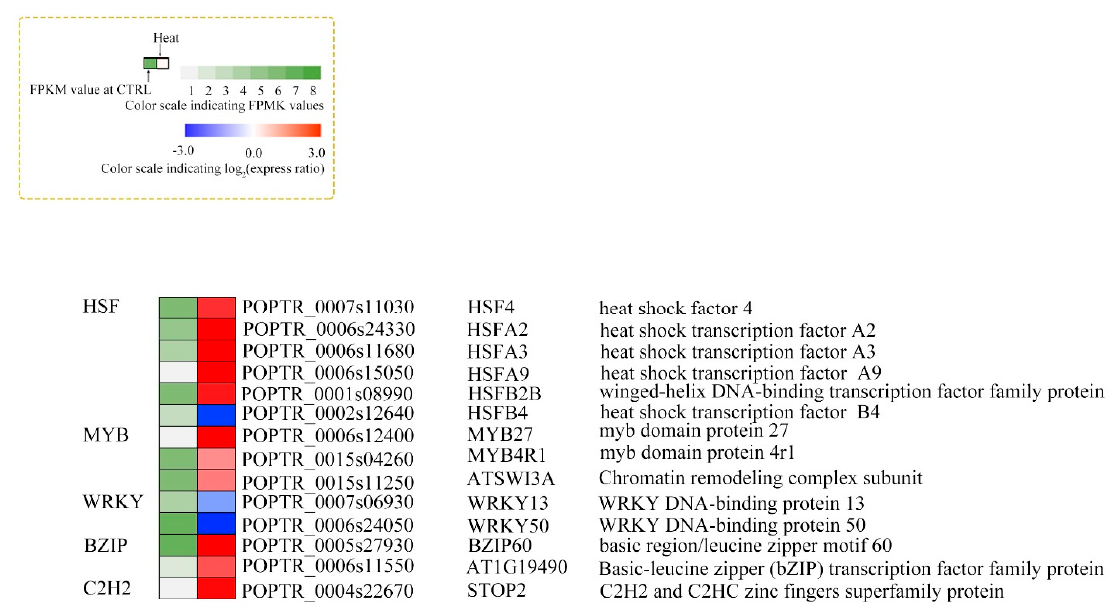
Figure 8. Heatmaps of changes in the expression of transcription factors under heat stress. Fourteen transcription factors (belonging to five groups) were differentially expressed.